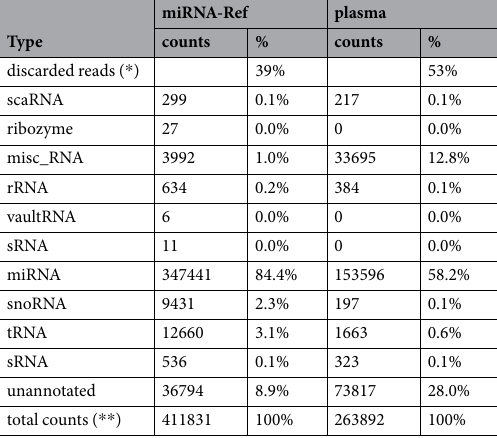
Starting plasma volume ( µ L)